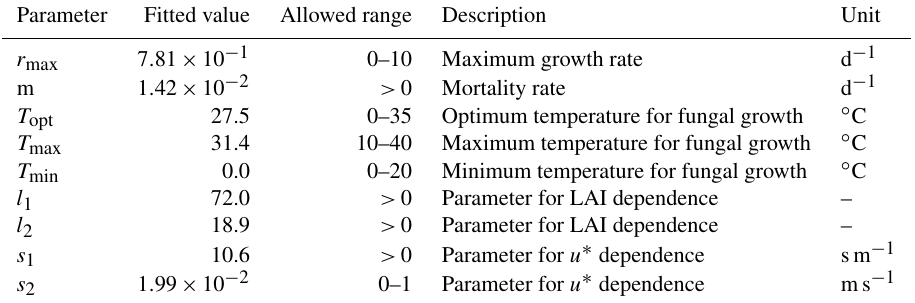
Figure 4. Model fungal spore emissions for the (a) statistical scheme, (b) population scheme and (c) HS09 scheme compared to the 20d running mean derived emission flux at all 66 AAAAI stations. Left panels show time series comparisons over 6 years; shaded areas show the standard deviation of the derived fluxes. Right panels show point-by-point comparison with statistics shown inset and the 1 : 1 line shown as a dashed line. Table 2. Fitted parameters of the population